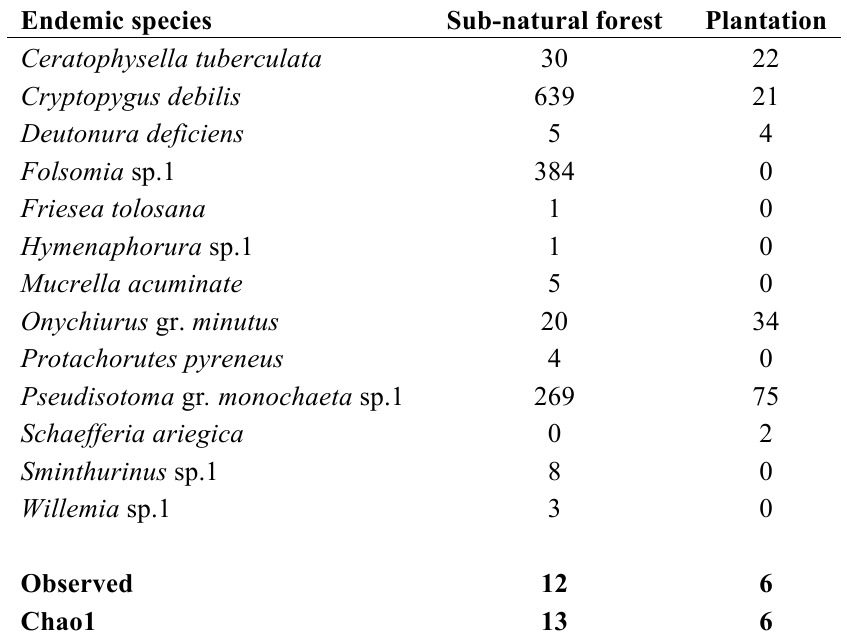
Table 2. List of endemic collembolan species and species richness indices. List of non-endemic species collected is given in Appendix